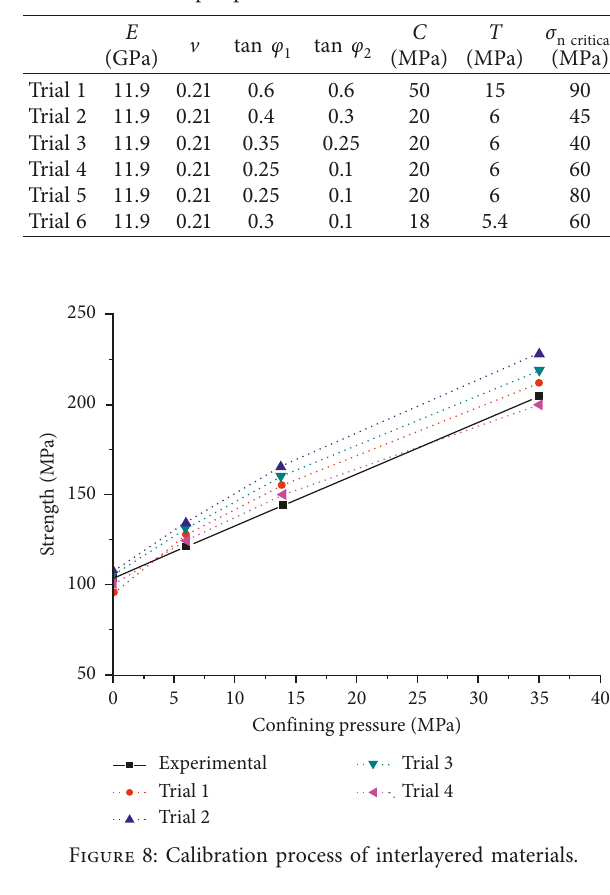
Table 3: Trial input parameters for calibration of material B.